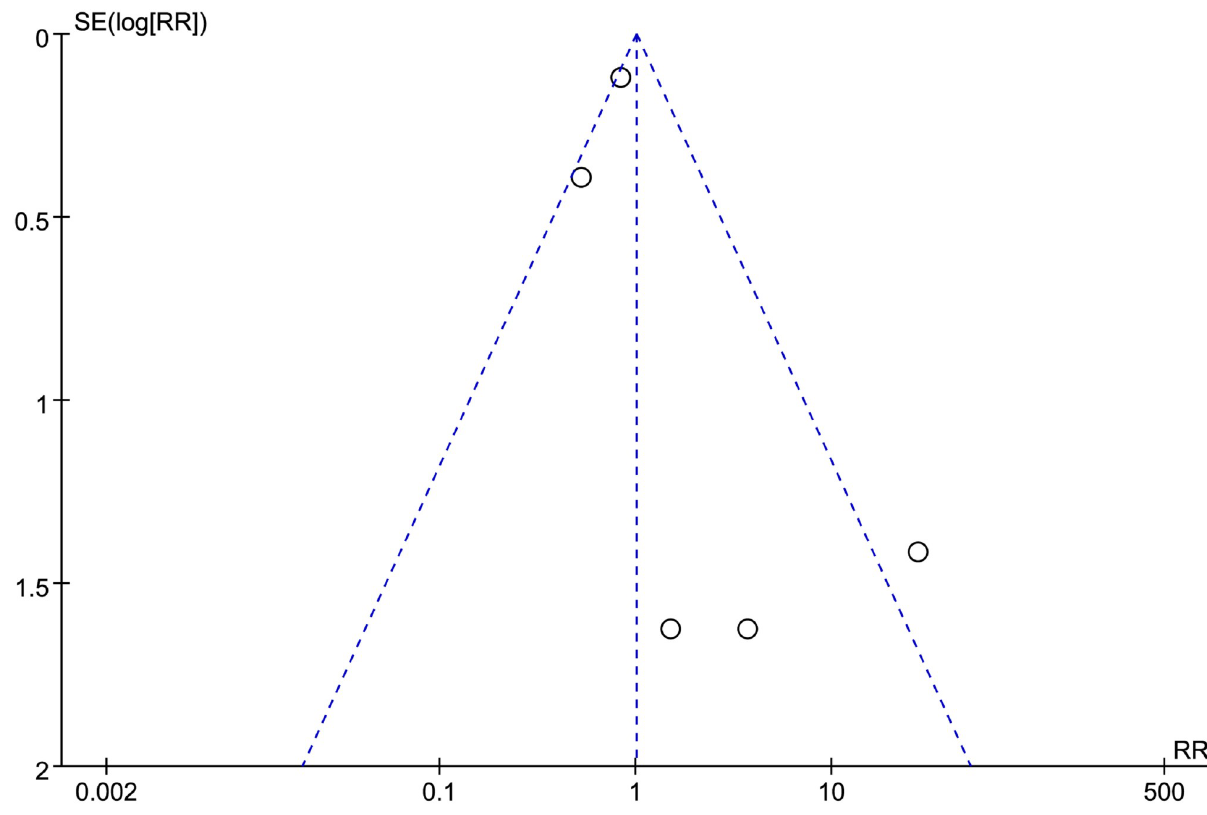
Fig 7. Adverse drug events